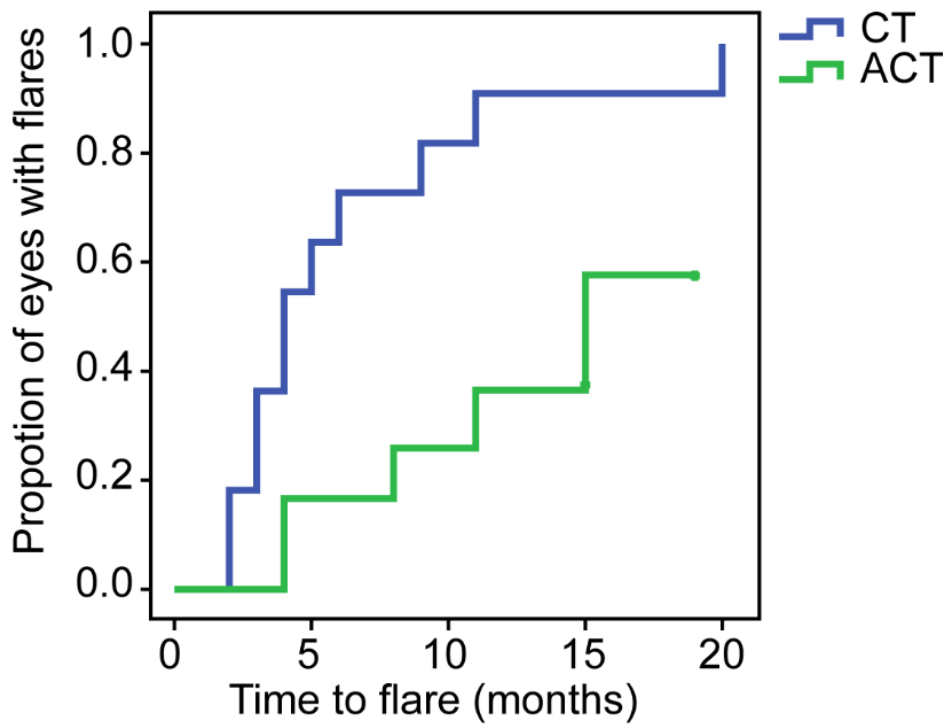
Figure 2. Kaplan–Meier curve of time to flare of scleritis since baseline. In the 20th month, flares occurred in 100% of the eyes in the CT (conventional therapy) group, and 7/12 (58.33%) eyes in the ACT (adalimumab plus conventional therapy) group remained without flares.